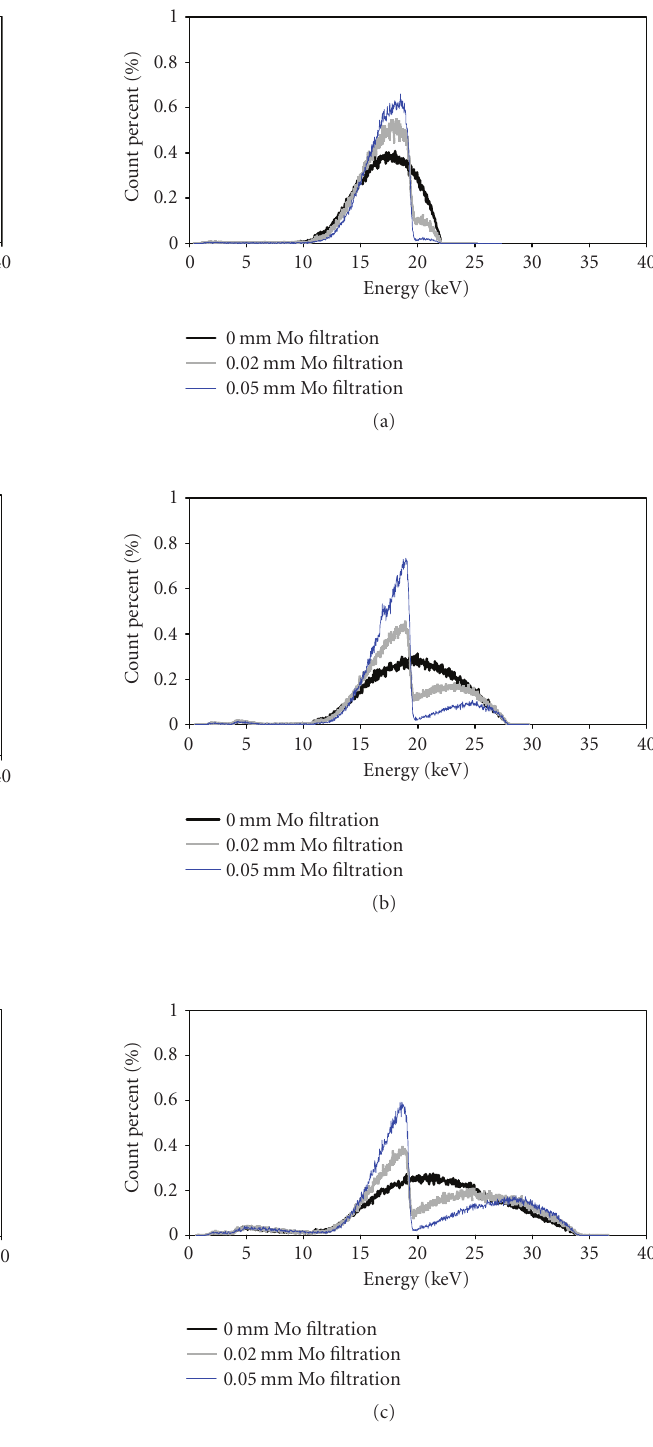
Figure 4: (a) X-ray spectra using the 2 . 15cm phantom under the exposure of 22kVp with a 0 . 0cm (thick curve), 0 . 02 cm (gray curve), and 0 . 05 cm (thin curve) Mo filter. (b) X-ray spectra using the 2 . 15 cm phantom under the exposure of 28kVp with a 0 . 0 cm (thick curve), 0 . 02 cm (gray curve), and 0 . 05 cm (thin curve) Mo filter. (c) X-ray spectra using the 2 . 15cm phantom under the ex- posure of 35kVp with a 0 . 0 cm (thick curve), 0 . 02 cm (gray curve), and 0 . 05 cm (thin curve) Mo